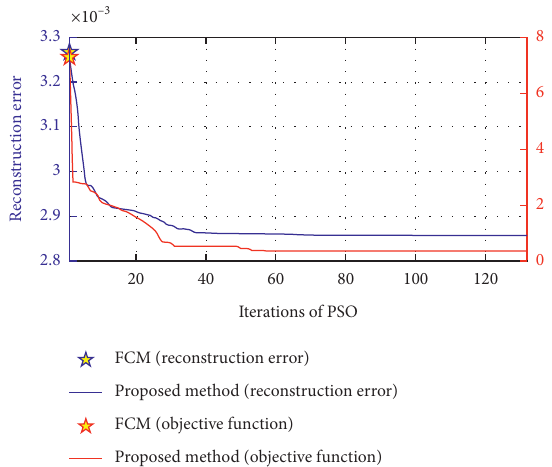
Figure 10: Convergence study on the predicting